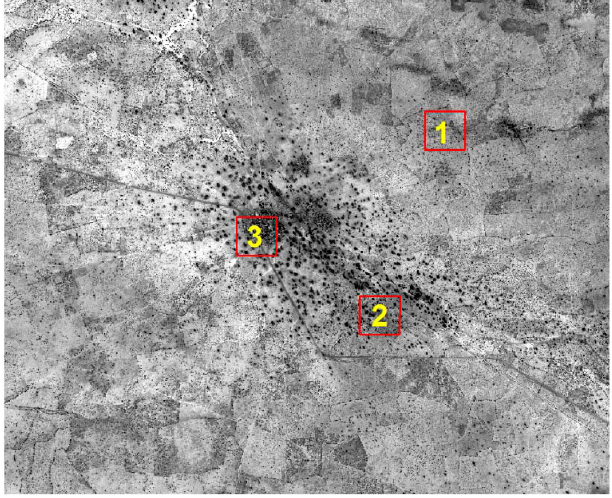
Figure 12. Ground truth sites. 1 . Croplands; 2 . Bottom of the valley; 3 . Village. Guileyni, 2011.